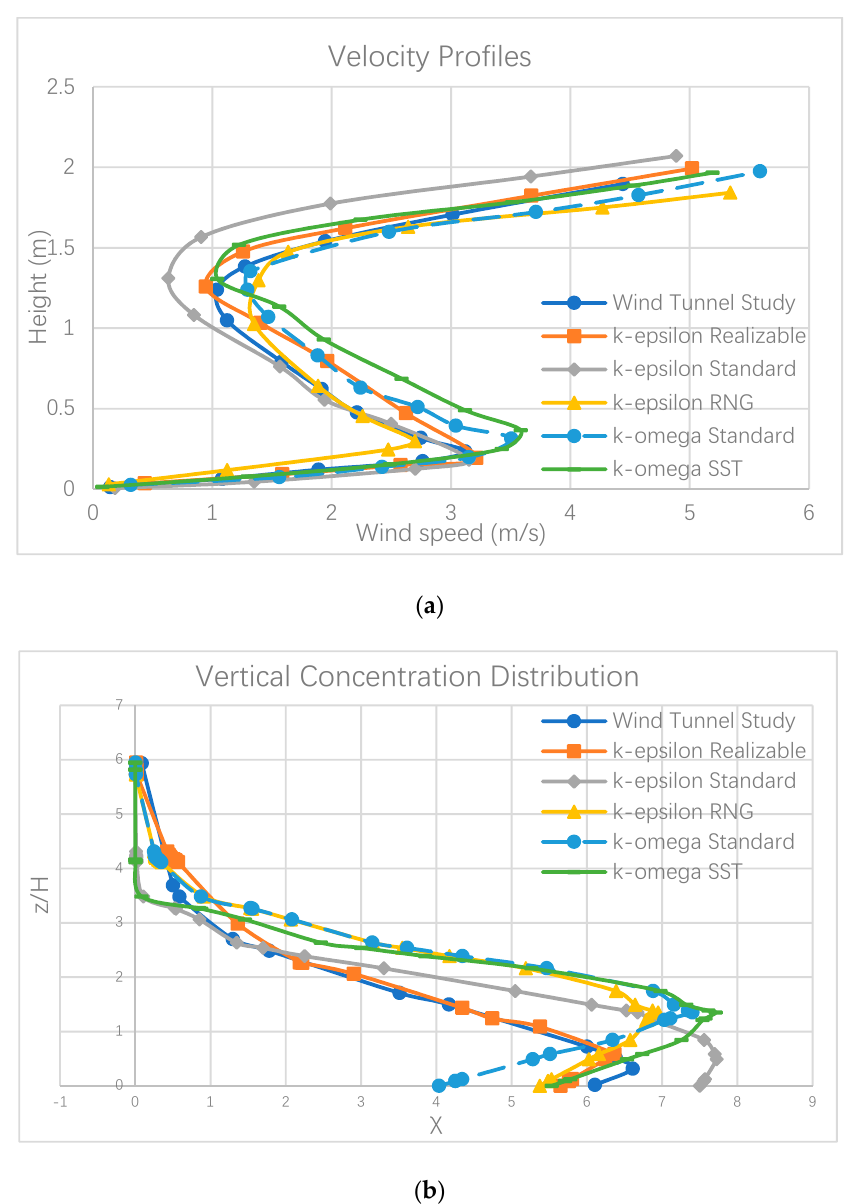
Figure 7. Turbulence model comparison. ( a ) Velocity profiles at x/H = 5; ( b ) vertical distribution of C 2 H 6 normalized concentration at x/H = 5.